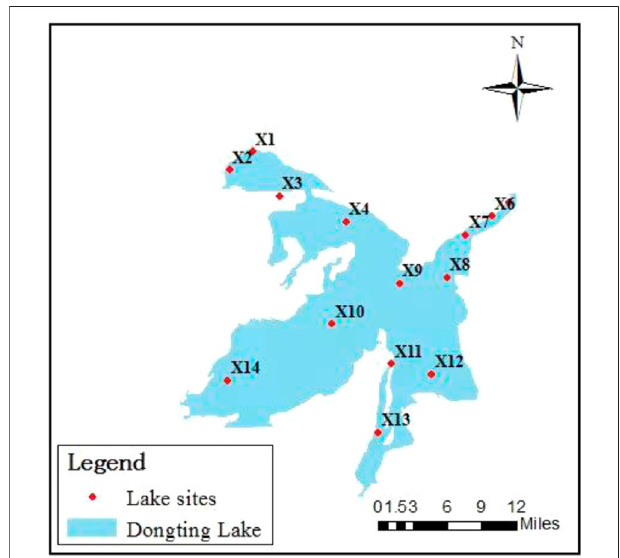
FIGURE 1 | Sampling sites in East Dongting